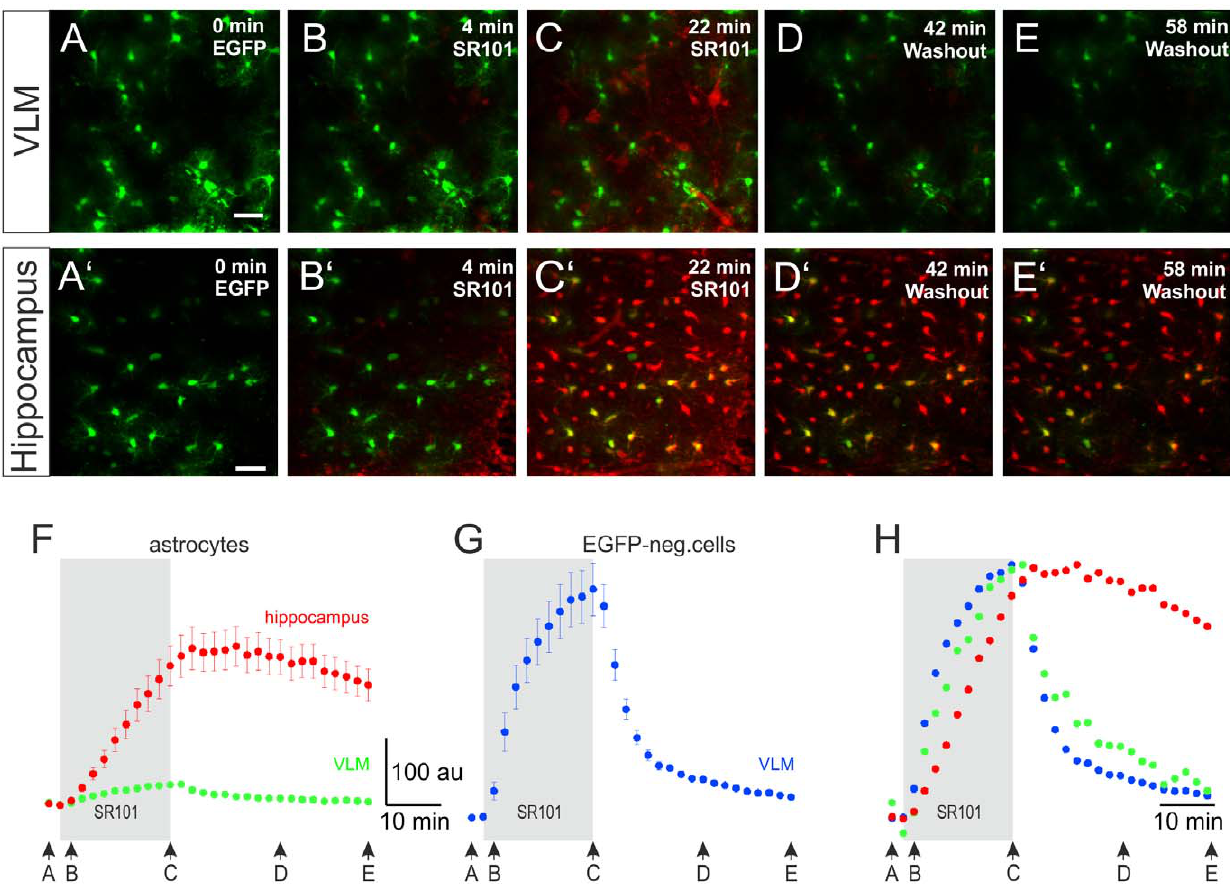
Figure 4. Time course of the SR101-staining procedure. ( A–E 9 ) Images show 2-photon time-lapse recording of SR101-stainings and unstaining during washout in acute slices (40 m m, 21 images, 0.5 min 2 1 ). A–E show the results from the ventrolateral medulla (VLM) and A 9 –E 9 from hippocampus. A, A 9 : Maximum intensity projections of the EGFP-fluorescence of the astrocytes. B–E, B 9 –E 9 : Images show maximum intensity projections of the SR101-labeling at 4 different time points in the hippocampus and in the VLM. Scale bars: 40 m m. F–H: Analysis of the time course of SR101-staining. Arrows underneath the traces represent the time points according to the images in A–E and A 9 –E 9 , respectively. Data (mean 6 SEM) is derived from 3–5 cells per slice (6 slices in hippocampus and 5 in the VLM). F: Note that the SR101-staining of hippocampal astrocytes (red) is much stronger than the staining in the VLM astrocytes (green). G: In the VLM additionally EGFP-negative cells are stained while SR101 is applied (blue trace) but the fluorescence is disappearing during the washout. H: Normalized time course of the staining of astrocytes (red in the hippocampus; green in the VLM) and EGFP-negative cells in the VLM (blue).